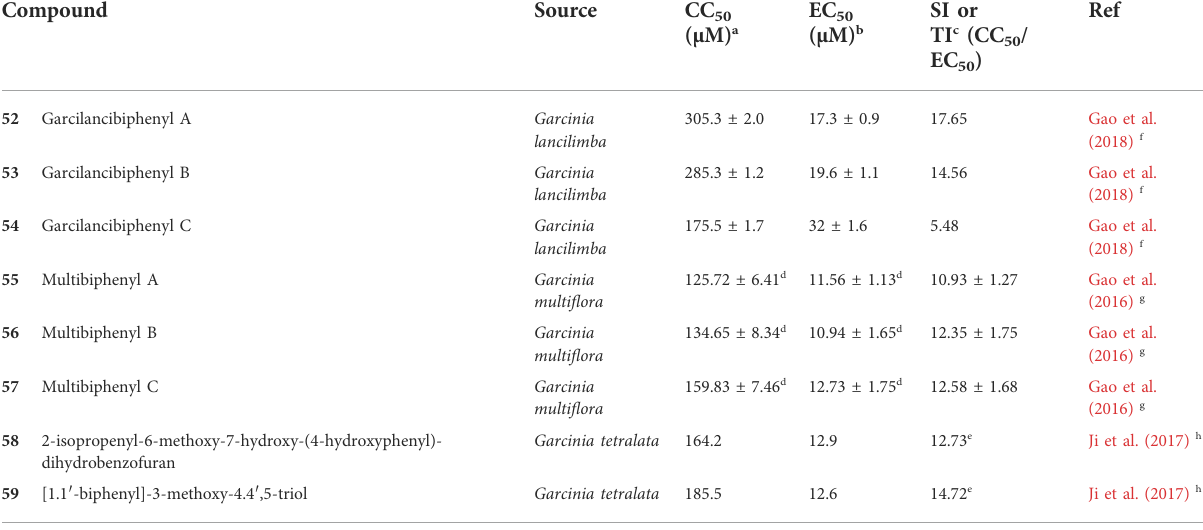
56 Multibiphenyl B